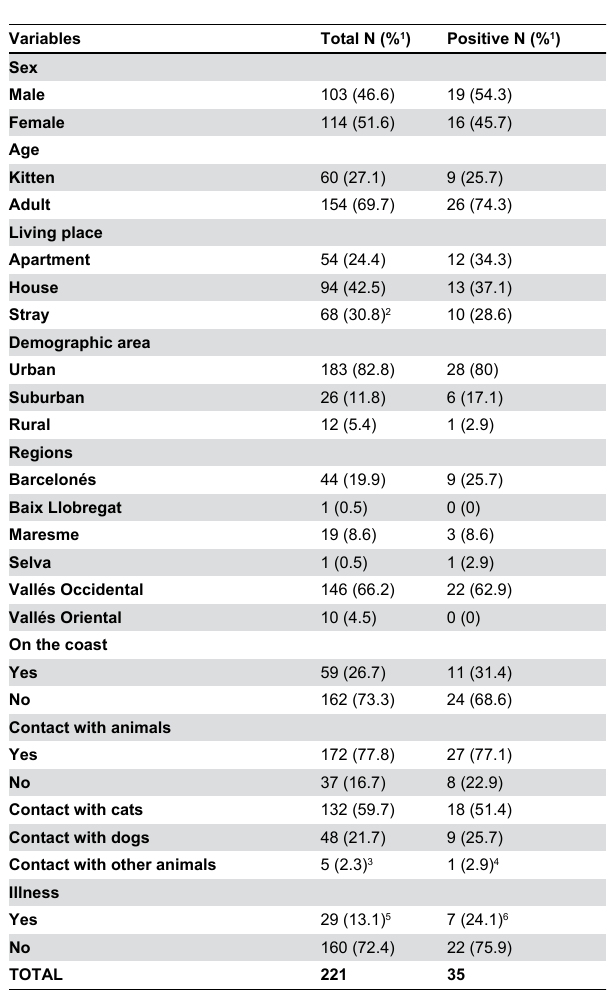
Table 1. Demographic information from cats tested for antibodies to Rickettsia typhi .